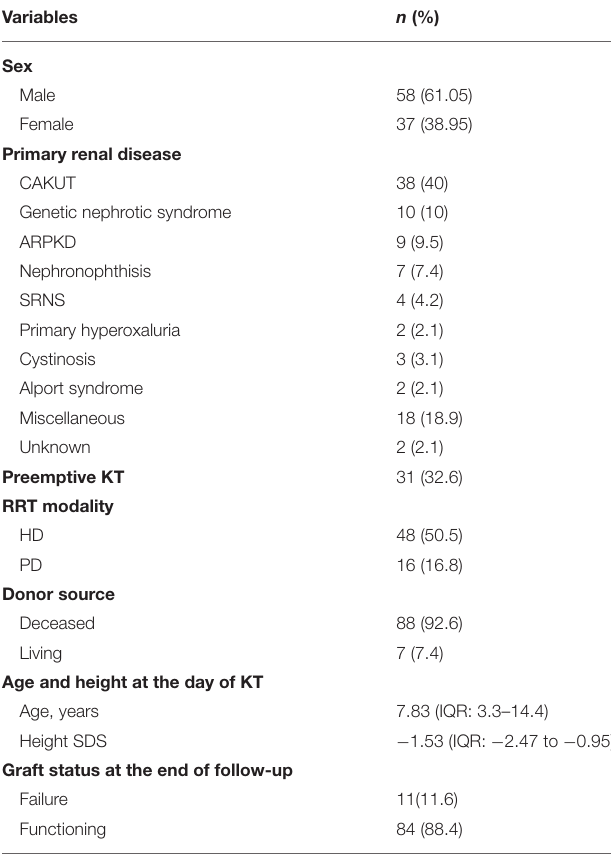
TABLE 1 | Baseline characteristics of the study